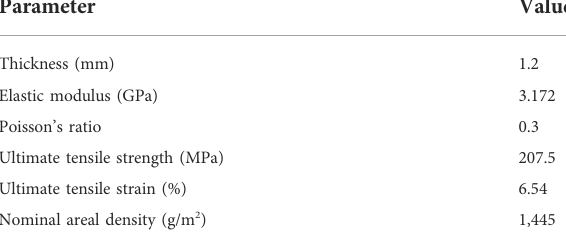
TABLE 1 Membrane speci fi cation.